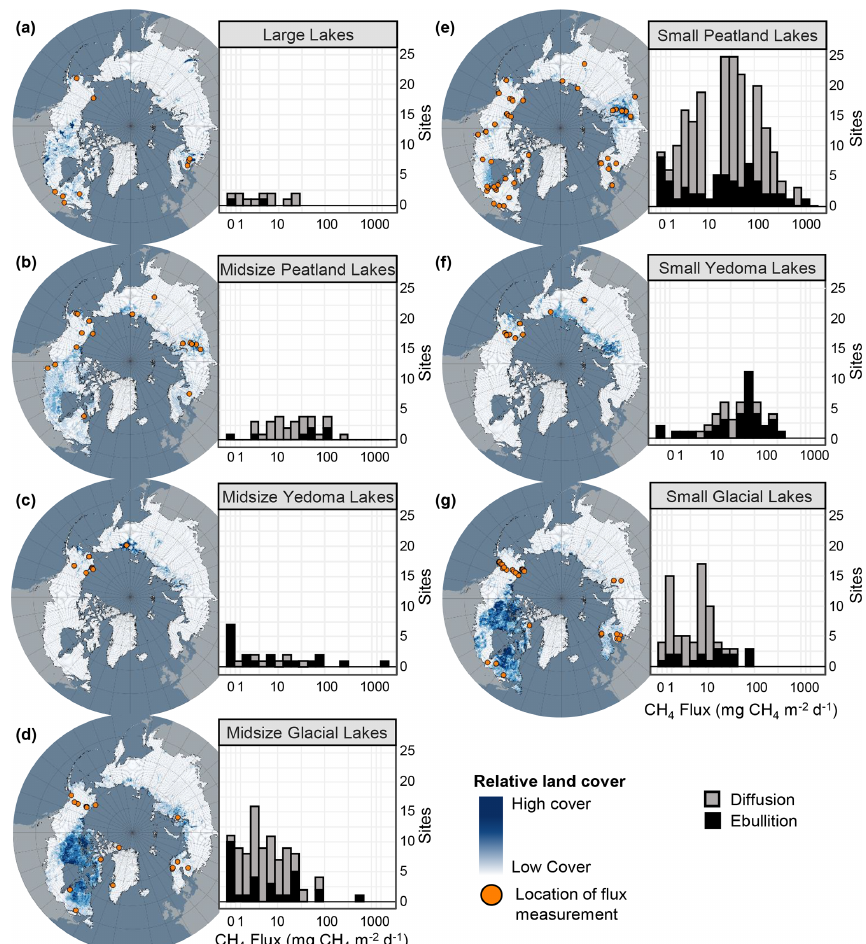
Figure 14. Flux frequencies and geographical distribution for each aquatic class. Relative land cover for each class type is represented in blue on the map. Site locations are represented by orange circles. Note the log scale for CH 4 flux. Land cover distributions from Olefeldt et al. (2021a, b). Histograms of non-transformed flux data are shown in Fig.